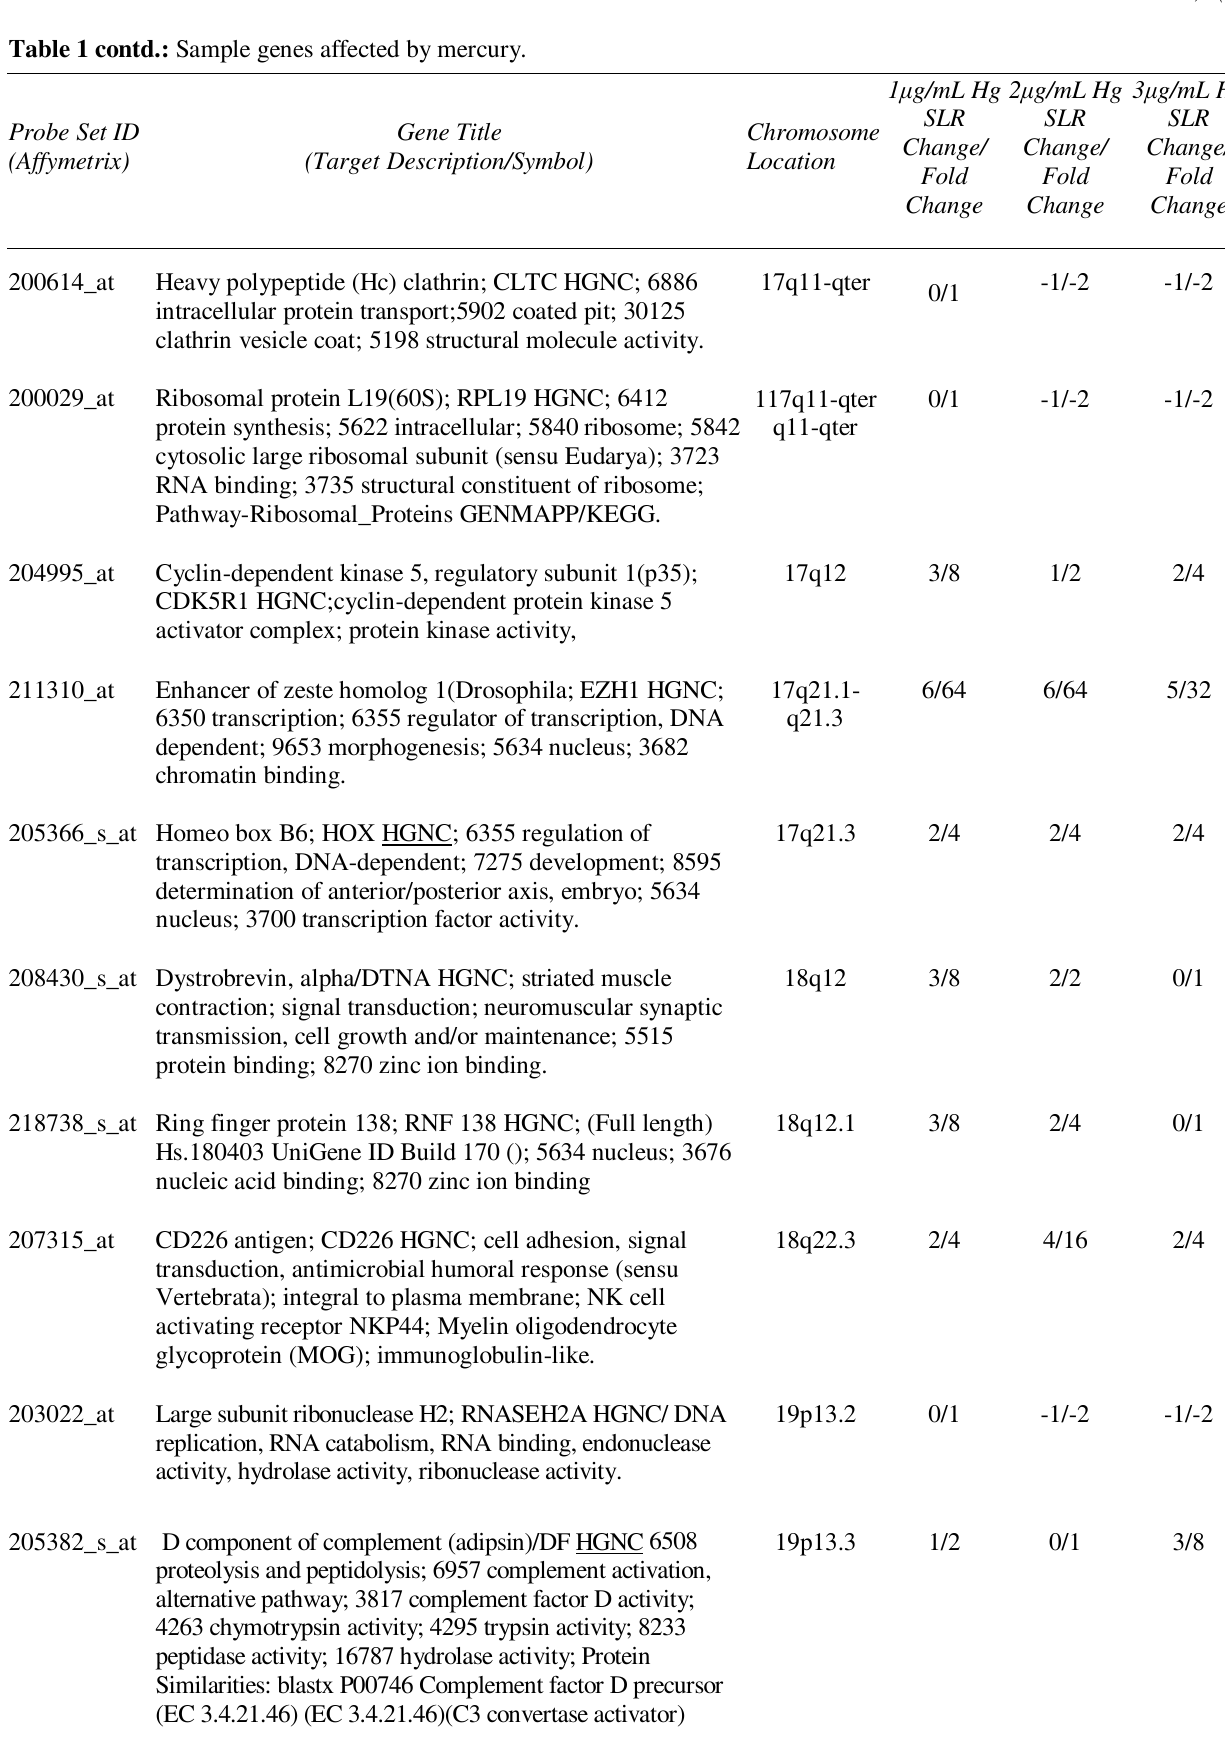
SLR-- signal log ratios